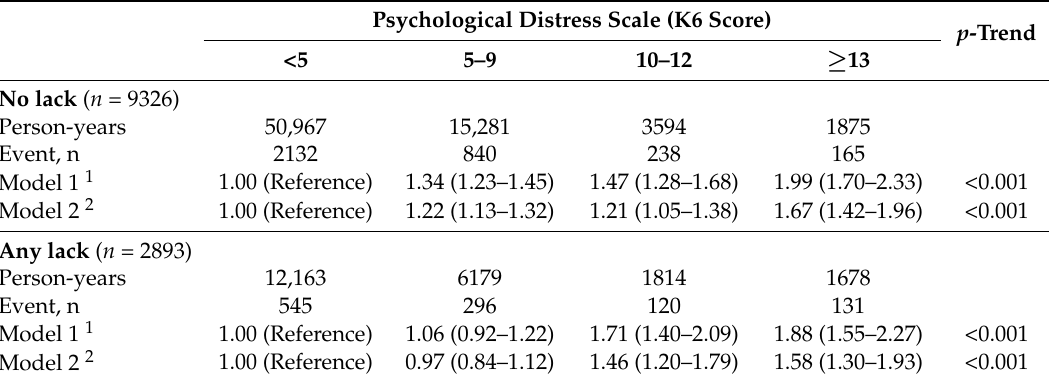
Table 6. Sensitivity analysis: stratified by social support